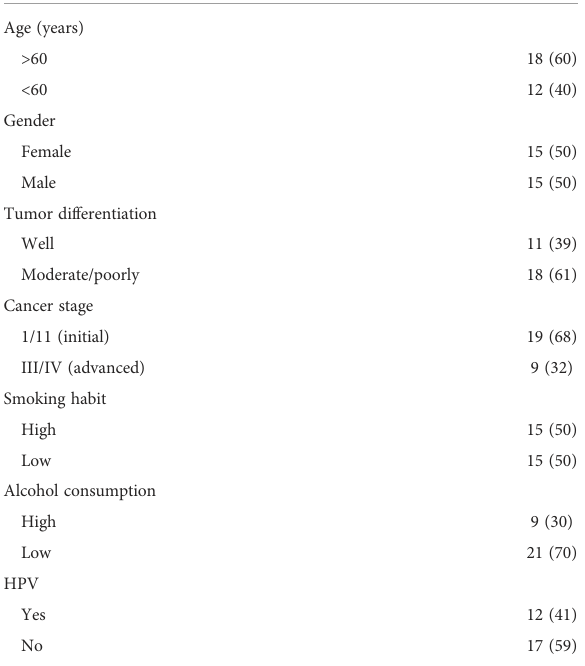
TABLE 1 Patient